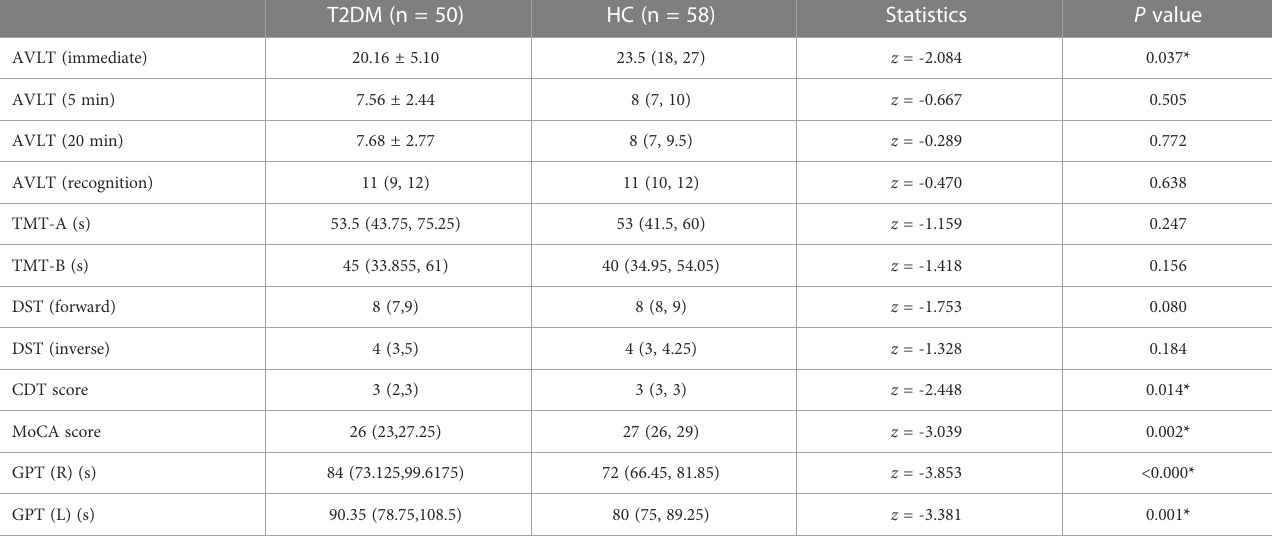
TABLE 2 Neuropsychological result of two